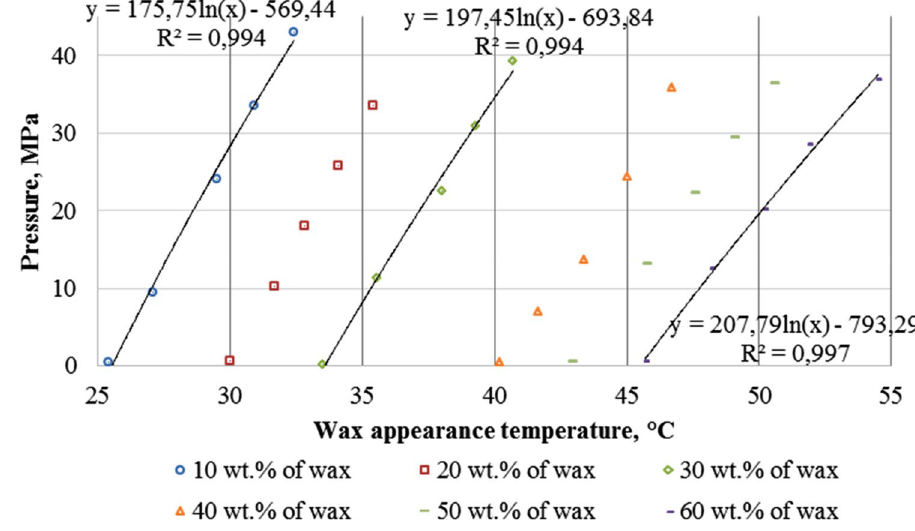
Fig. 10 Pressure versus WAT for different wax concentration in kerosene (Struchkov and Rogachev